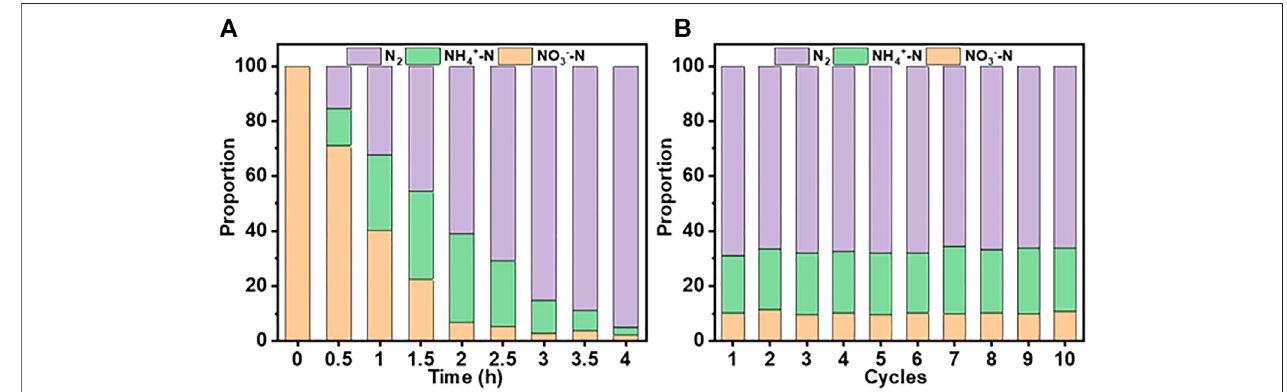
FIGURE 10 | Effects of reaction time and initial NO 3 − -N concentrations on the operational ef fi ciency. (A) and (C) EC; (B) and (D) CE (pH, 7.0; current density, 15 mA/cm 2 ; [Cl − ], 2000 mg/L; reaction time, 2 h).